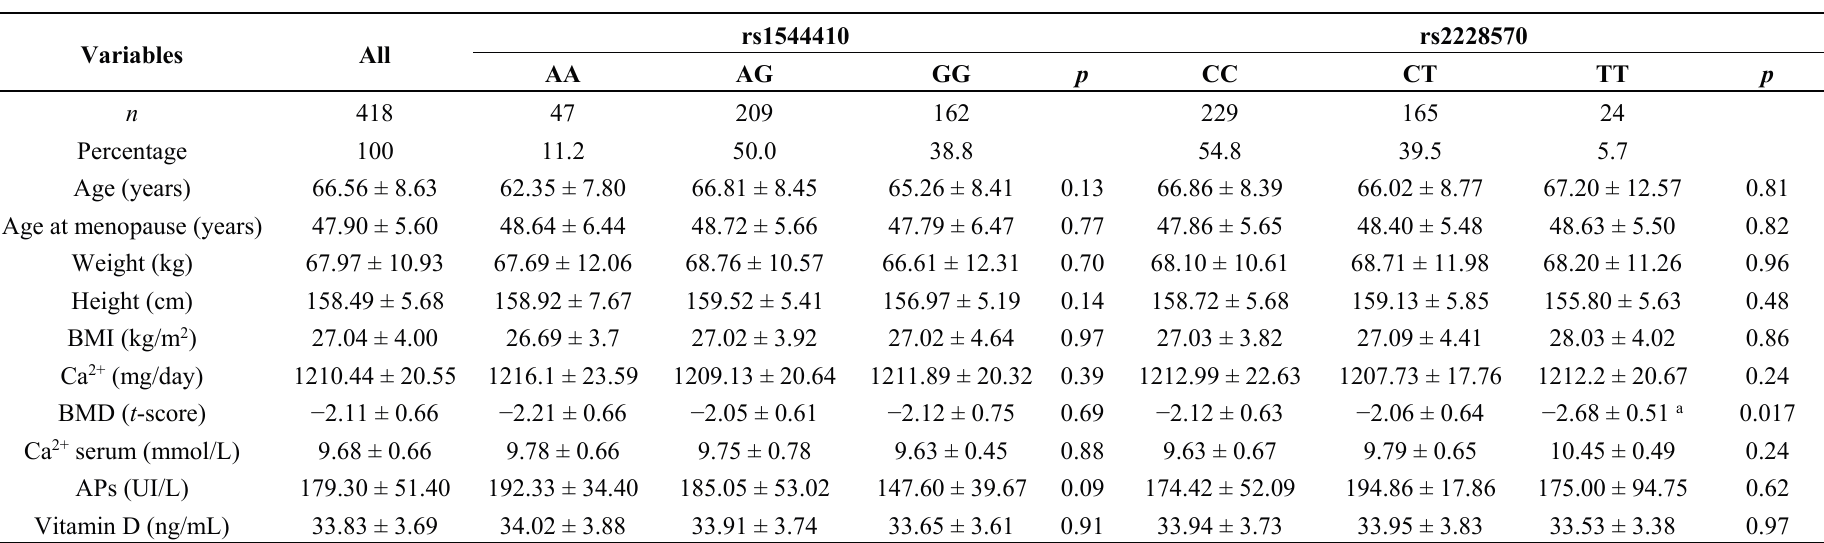
Table 1. Characteristics of all subjects and according to the rs1544410 and rs2228570 genotypes.